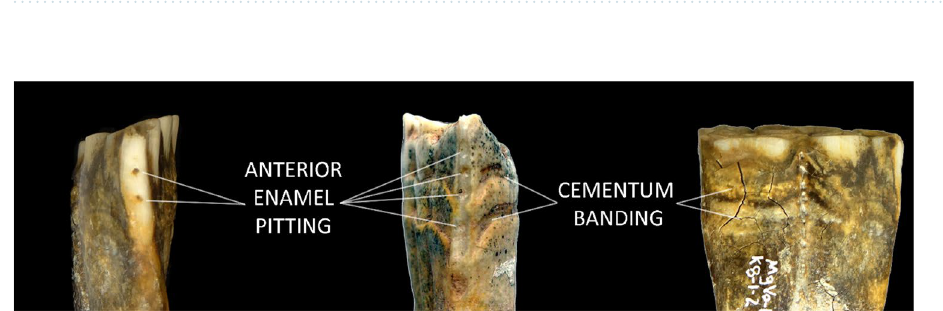
Table 3. Diastema bone formation score in six Pleistocene horse mandibles from the Wally’s Beach site, Alberta.